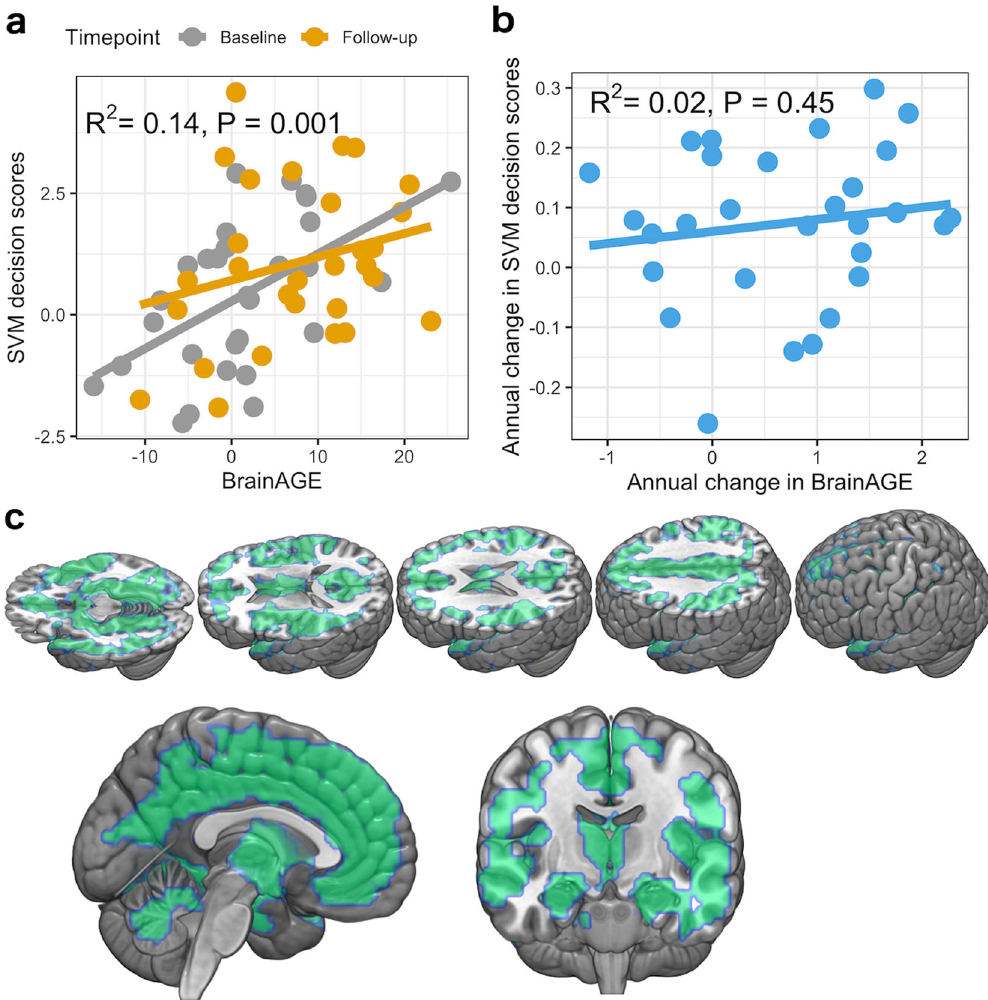
Fig. 3 The relation of the SZ-HC model and brain aging over time. a The relationship between SVM decision scores and BrainAGE as a coef fi cient of determination from a linear mixed model. b The relationship between the annual change in BrainAGE and annual change in SVM decision scores. c The brain regions of which atrophy over time contributes to the corresponding increment in BrainAGE (Threshold-Free Cluster Enhancement-corrected P value <